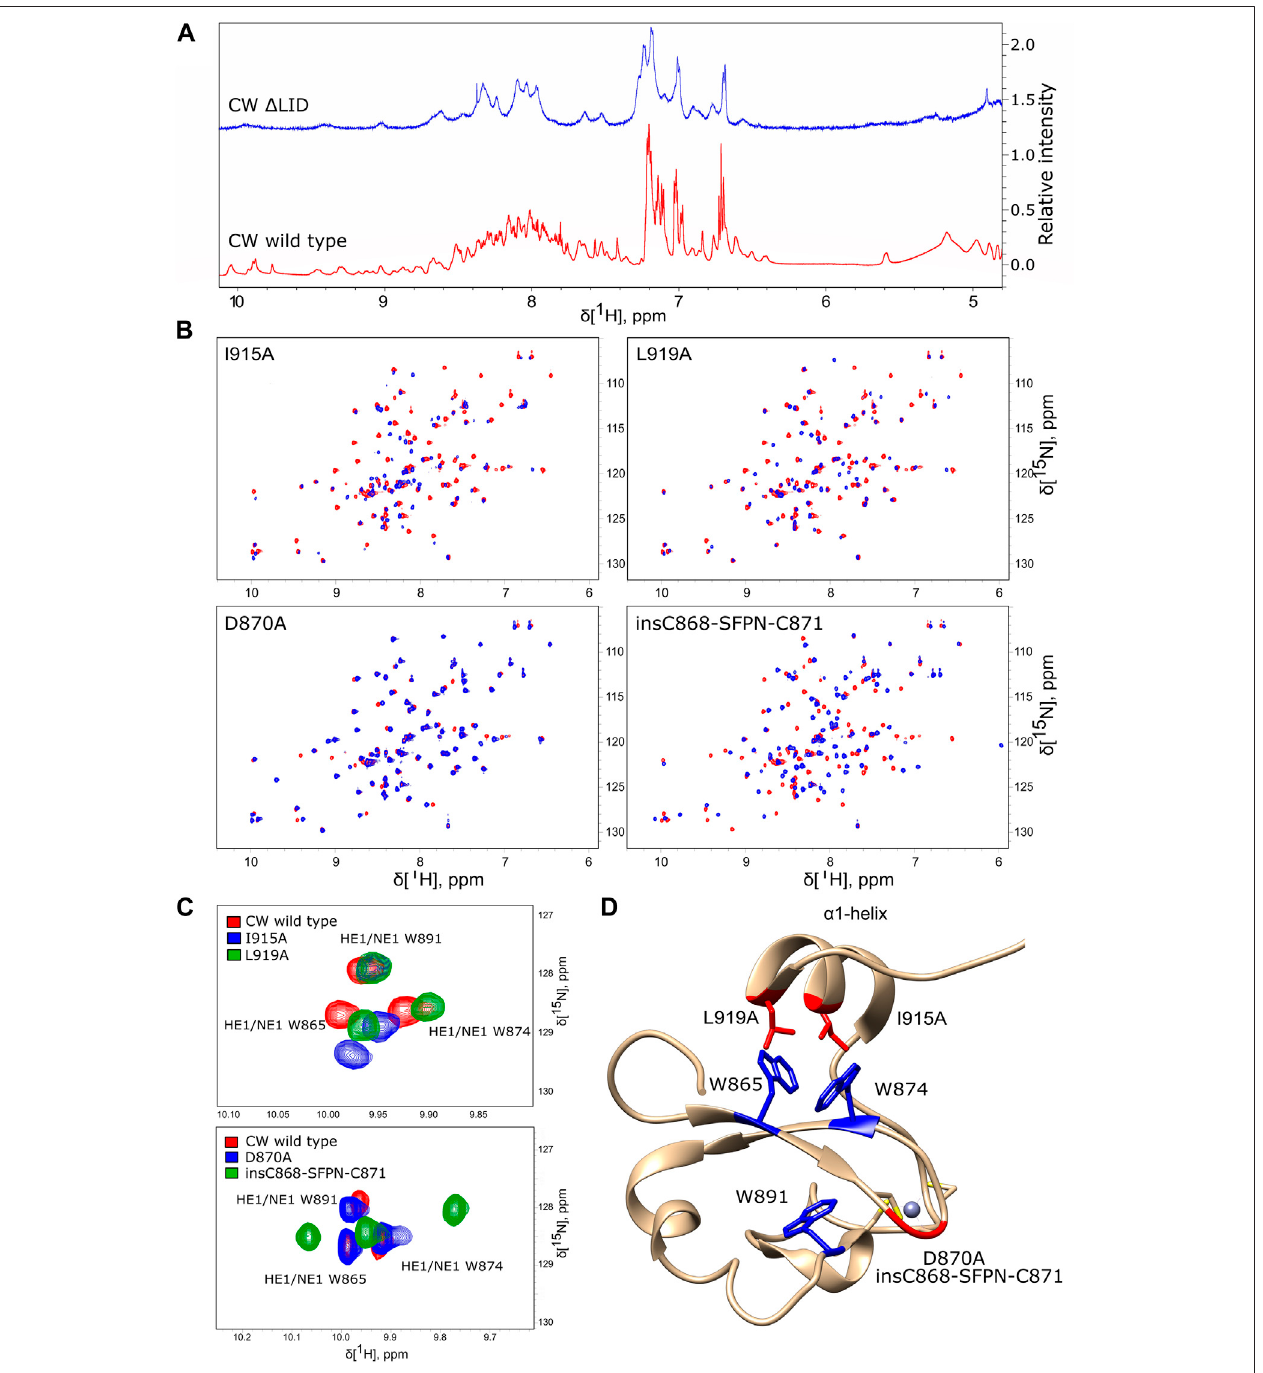
FIGURE6| Mutation-inducedstructuraldisturbancesanalyzedbyNMR. (A) ProtonspectrumofCW Δ LID(blue)comparedtotheprotonspectrumofwild-typeCW (red).TheCW Δ LIDtracehasbeenshiftedupby1.5relativeunitstomakecomparisoneasier. (B) 15 NHSQCspectraofI915A,L919A,D870A,andinsC868-SFPN-C871 (blue color) overlaid with the spectra of WT CW (red color). (C) The effect of mutations in the α 1-helix (red, WT CW; blue, I915A; and green, L919A (top panel)) and the effect of mutations in the loop between β -sheets (red, WT CW; blue, D870A; and green, insC868-SFPN-C871 (bottom panel)). (D) Location of the point mutations (red sticks) and insertion mutations (red backbone trace) mapped on the CW structure (PDB: 2L7P ). The tryptophans are highlighted in blue; grey sphere isthe Zn 2+ ion coordinated by cysteins (yellow).